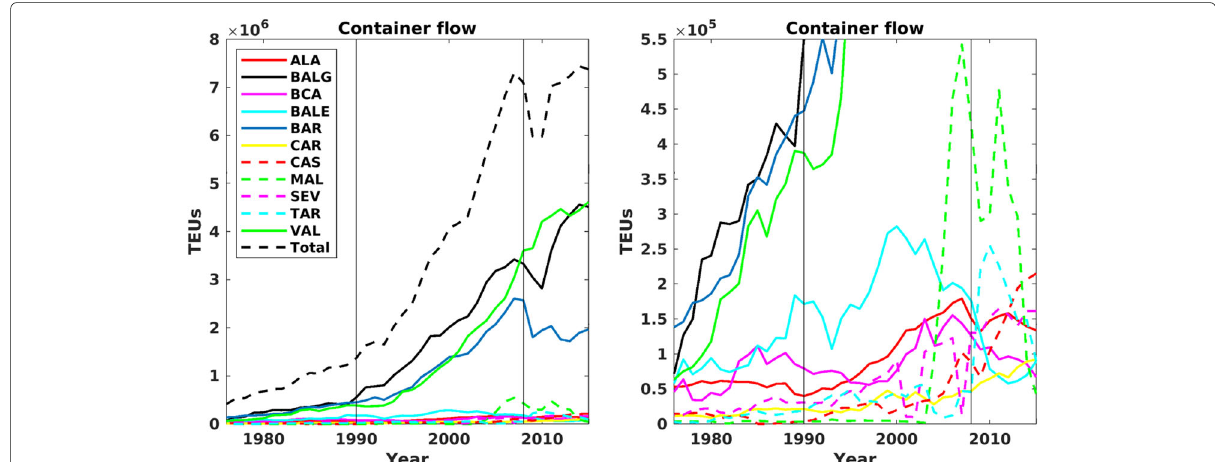
Fig. 2 (left) Evolution of the total container throughput at SpanishMed ports. (right) Zoom of the lower range of the total container throughput. The three biggest ports are BALG (black line), BAR (blue line) and VAL (green line). Reference lines for years 1990 and